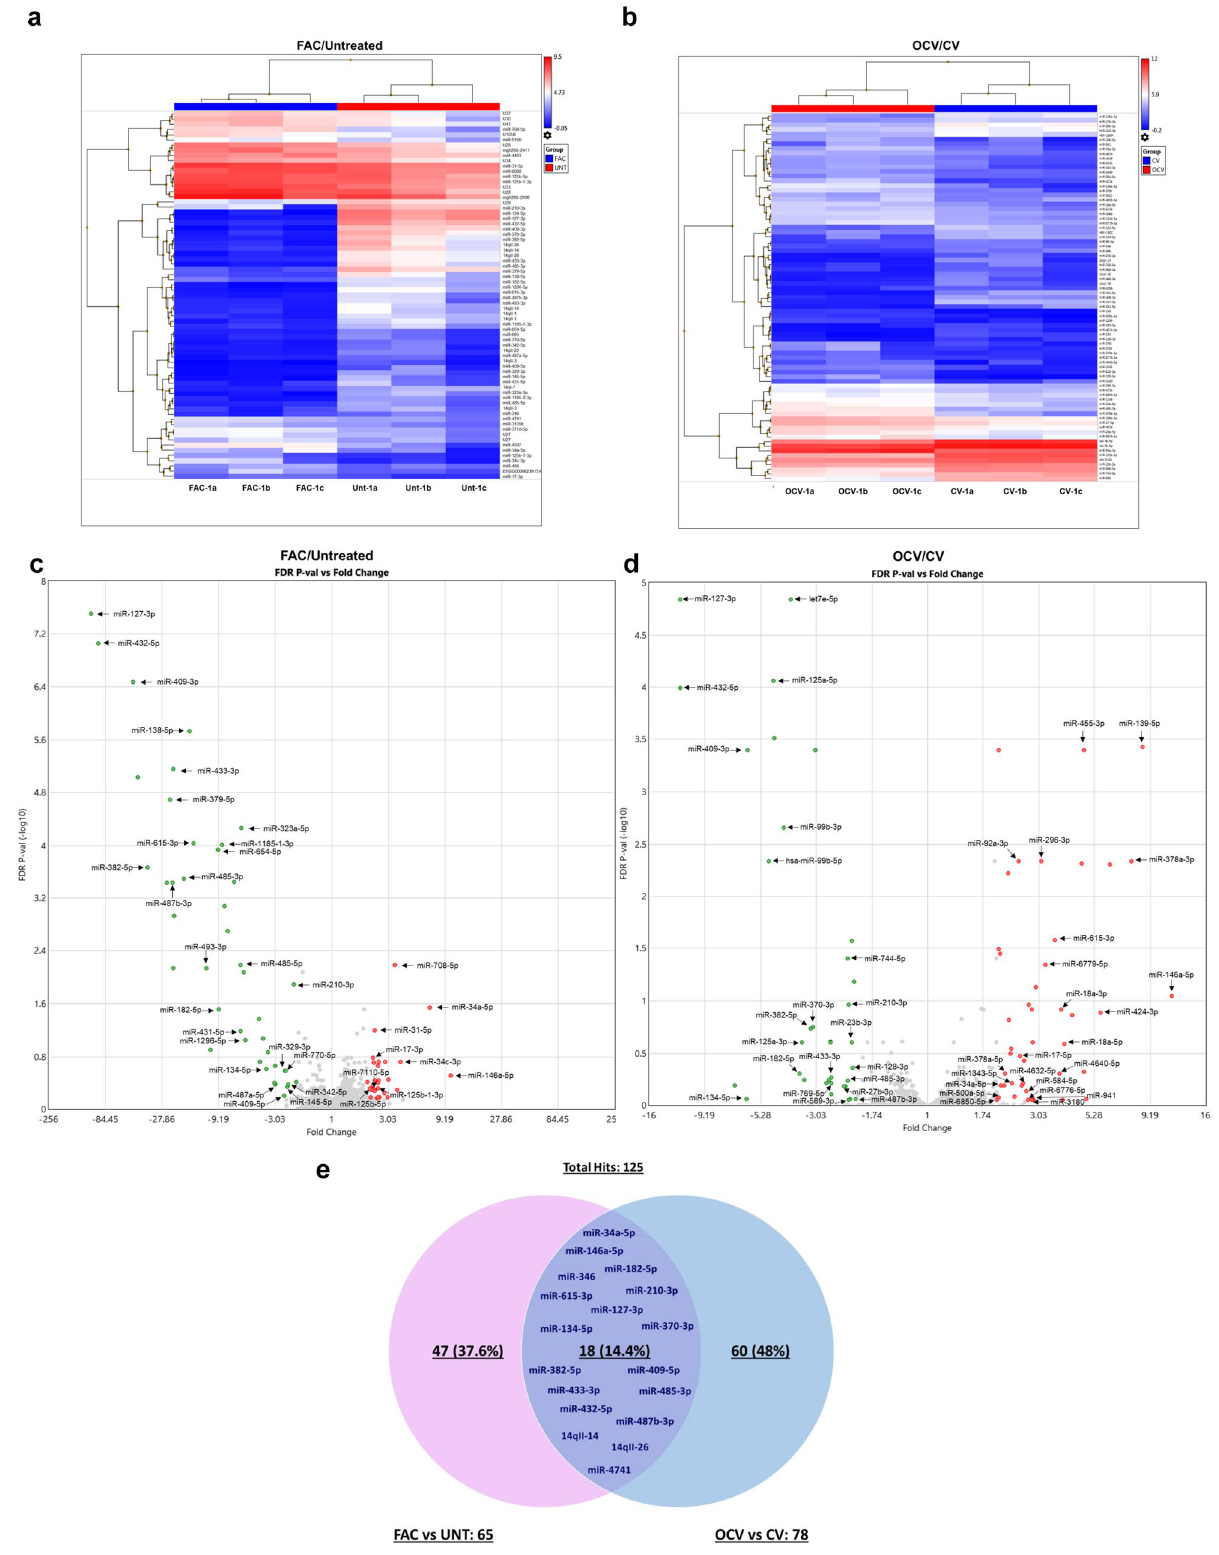
Figure 2. Altered miRNAs identified from microarray analysis in FTSECs. Heat Map representing miRNAs derived from the microarray analysis showing a decrease (Blue) and increase (Red) in miRNAs with ( a ) FAC treatment (FAC-1a, 1b, 1c) compared to Untreated and ( b ) transformed OCV- relative to CV-infected FT194 cells. Dysregulated miRNAs are displayed as Volcano Plots in ( c ) FAC-treated vs Untreated FT194 cells, ( d ) Transformed (OCV/CV) and, ( e ) dysregulated miRNAs are displayed in a Venn diagram showing 18 common (overlapping) miRNAs between FAC- treated relative to Untreated as well as transformed OCV relative to CV